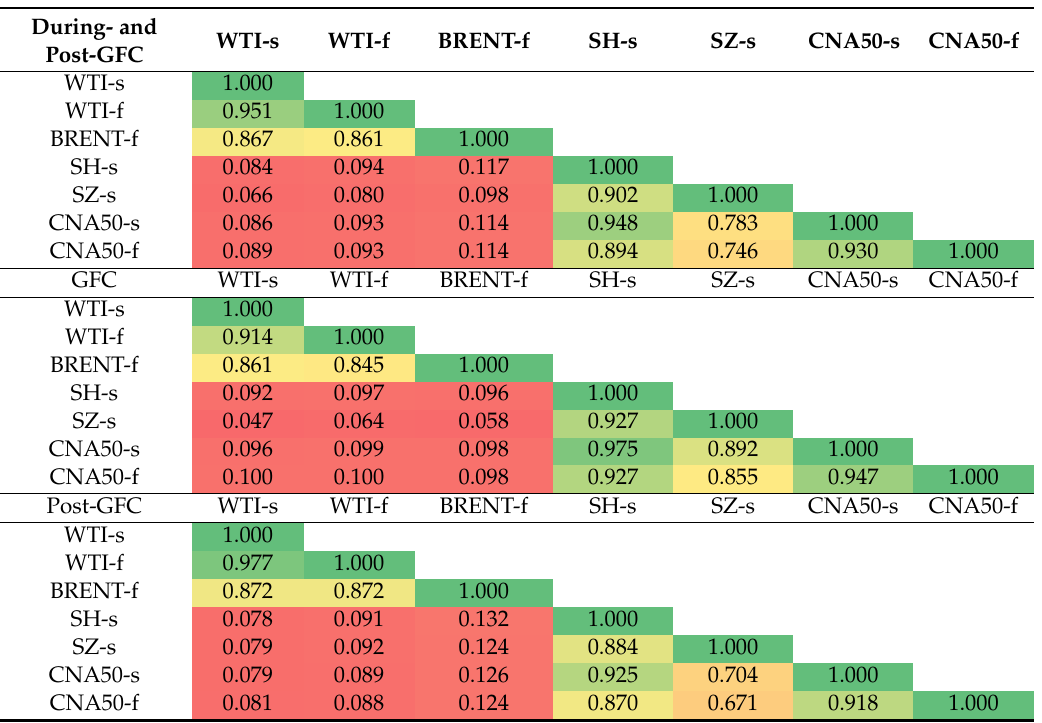
Table 4. Correlations of crude oil in the UK and the USA and financial markets in